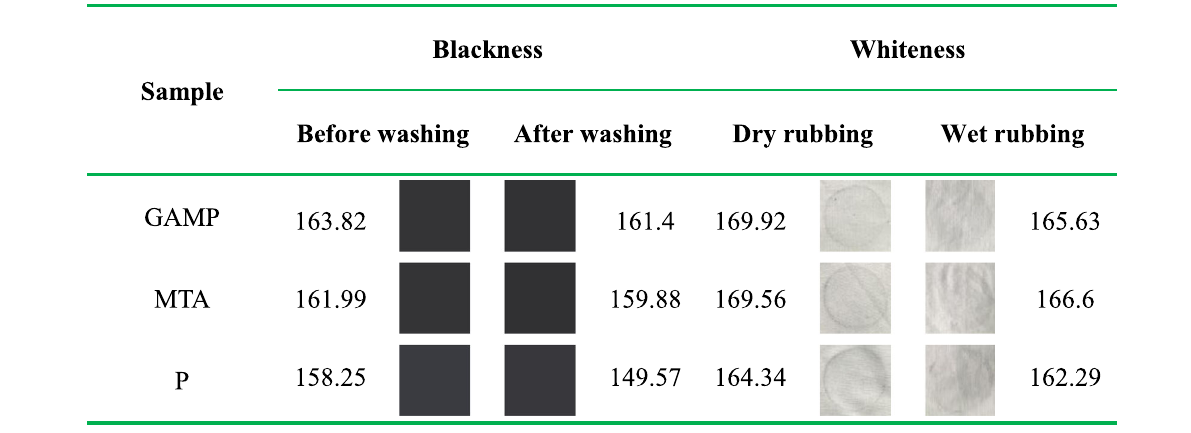
rubbed on the dyed